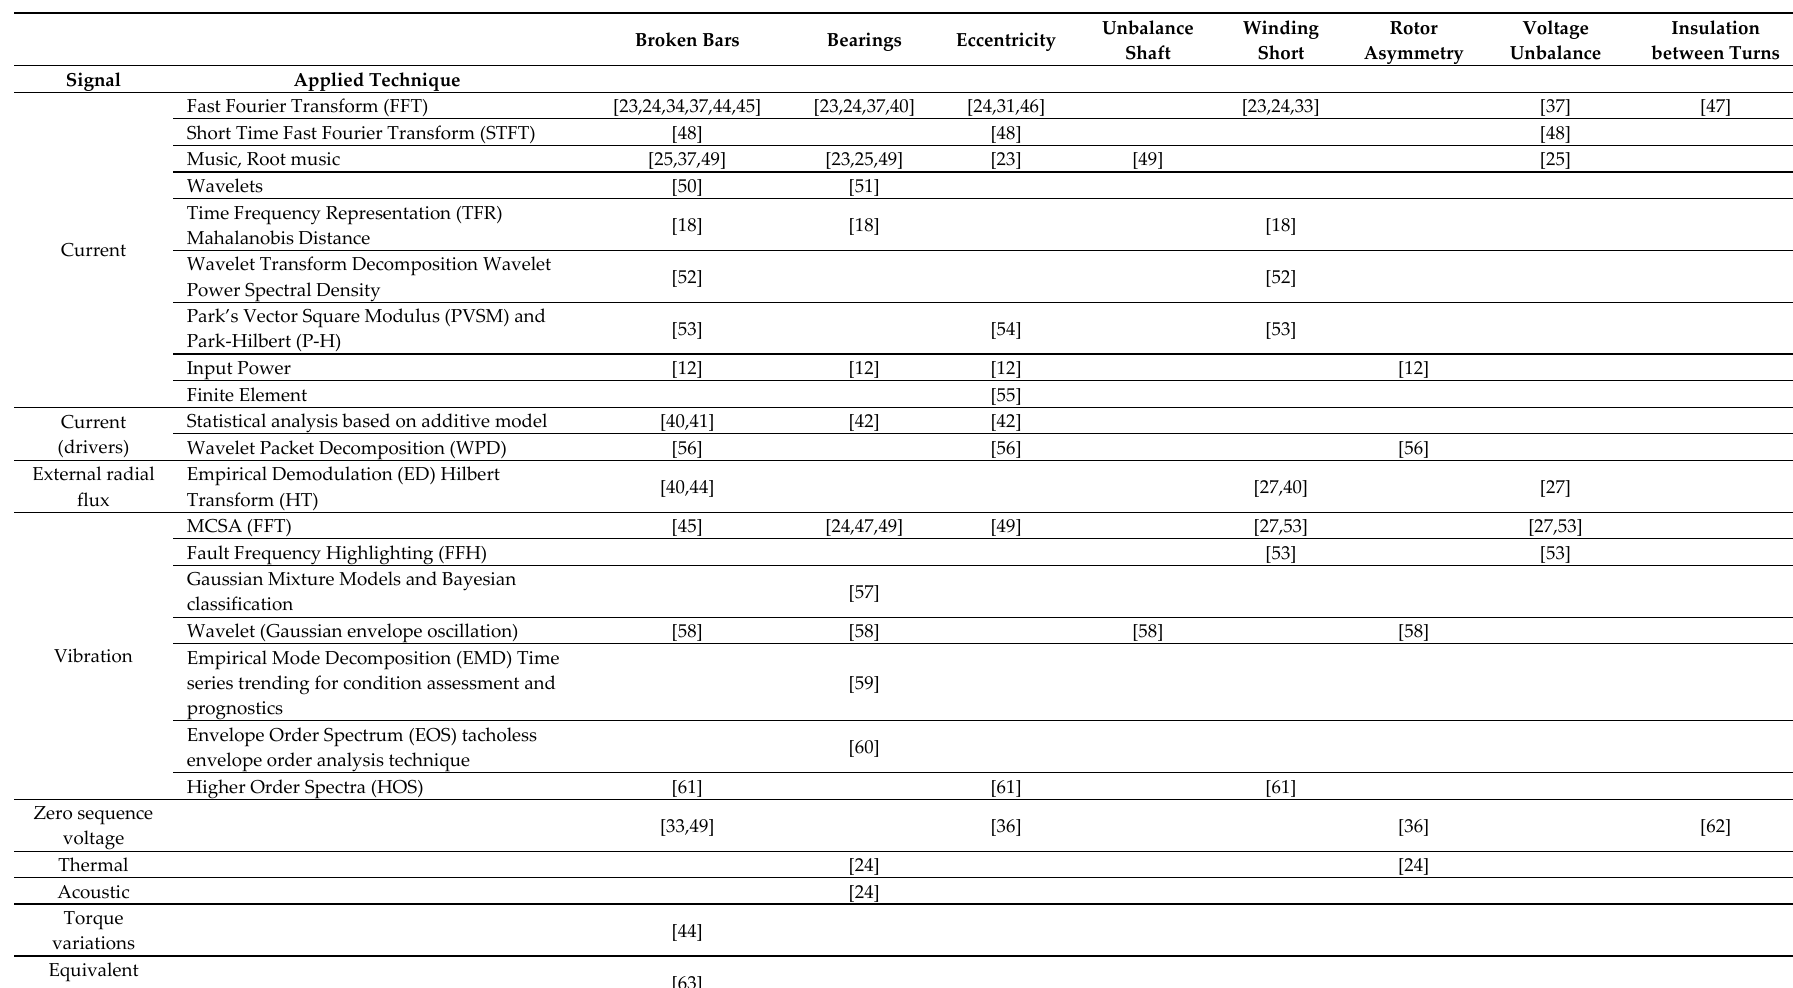
Table 10. Publications according to applied methodology and detected failures. Broken Bars Bearings Eccentricity